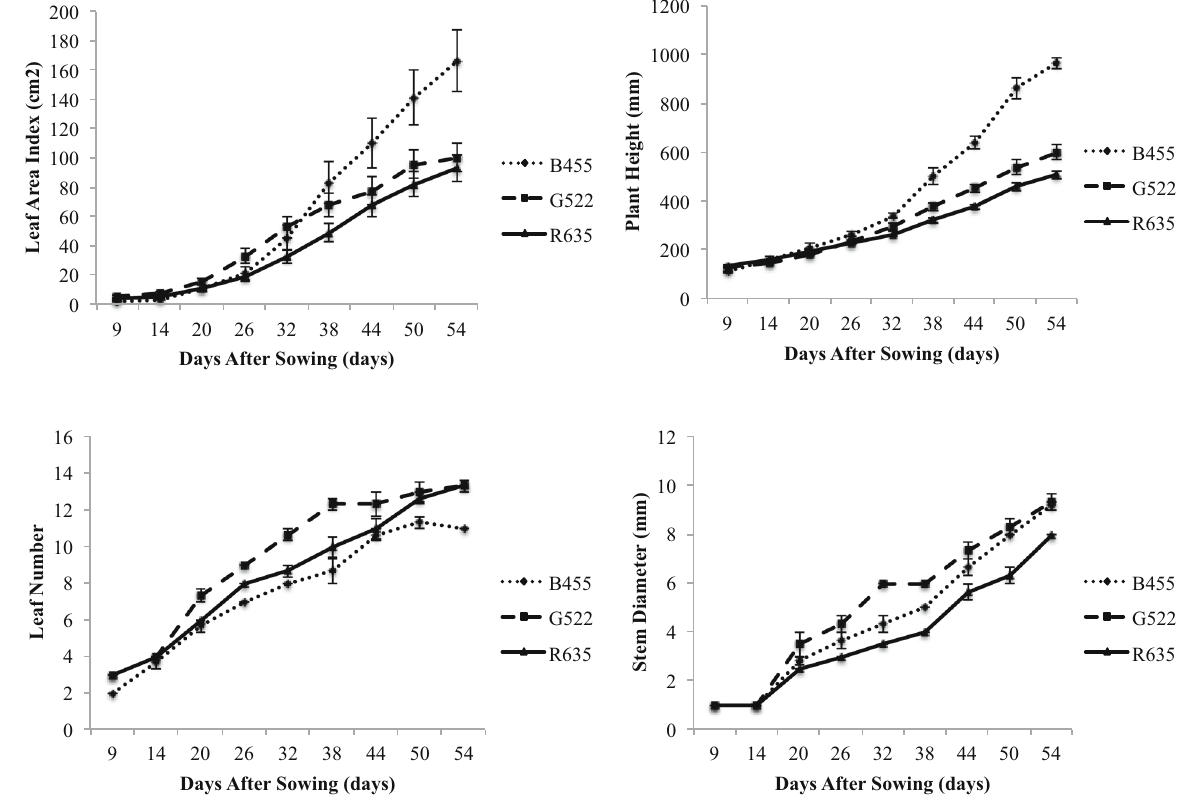
Figure 4: Evolution of leaf area, leaf number, plant height, and stem diameter during 54 - day growing period of okra ( Abelmoschus esculentus L. ) plants. The bars represent standard